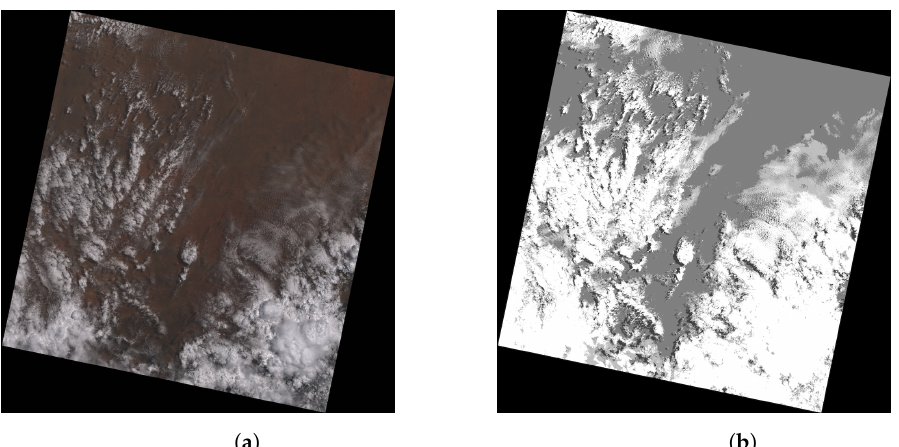
Figure 1. L8 Biome dataset image patch example ( a ) reconstructed from bands B4, B3, and B2 with its associated multi-class cloud mask ( b ) [35]. ( a ) Image patch. ( b ) Cloud validation